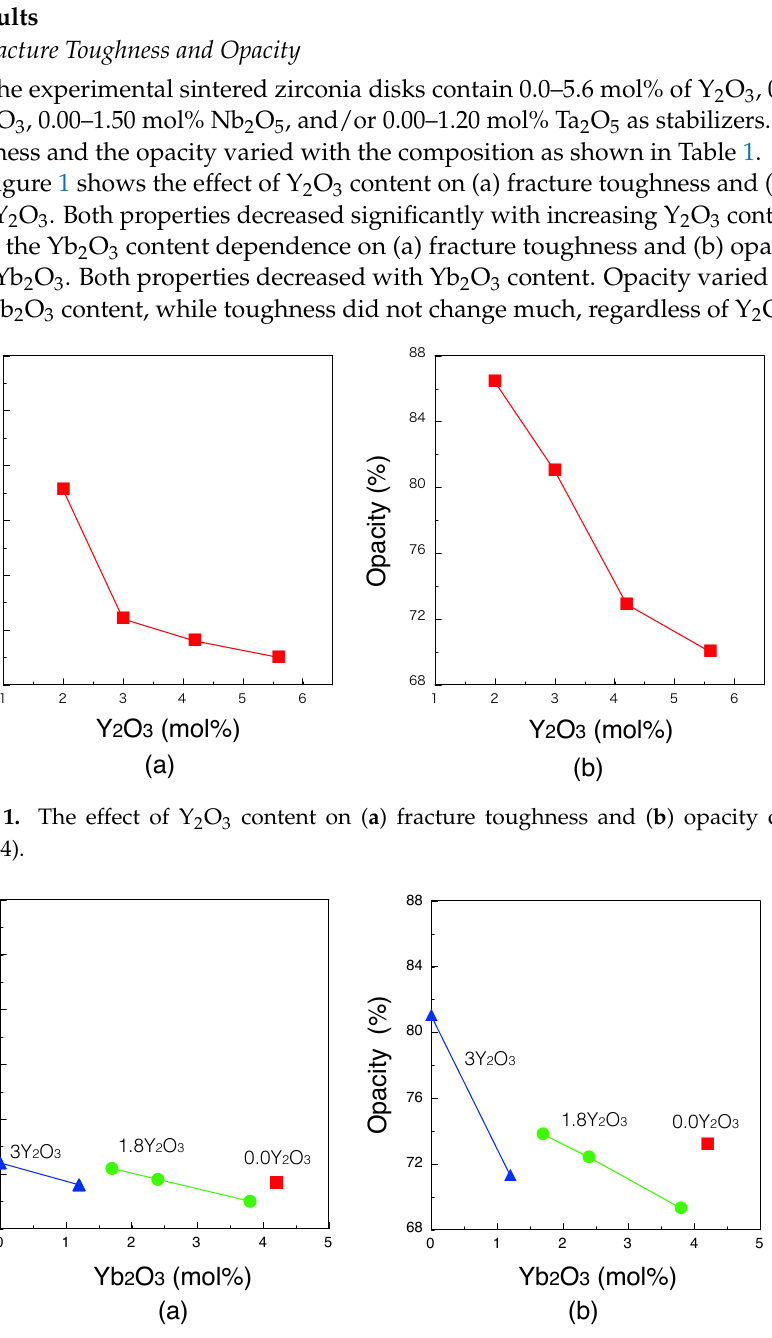
Figure 2. The effect of Yb 2 O 3 content on ( a ) fracture toughness and ( b ) opacity of ZrO 2 -Y 2 O 3 -Yb 2 O 3 (No. 2 and 5–9).